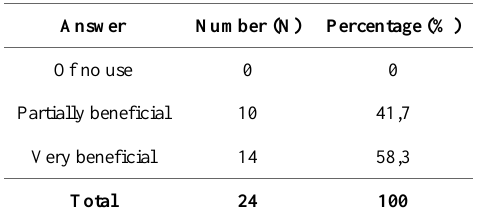
Table 2. Evaluation of the benefits from the Course in Academic